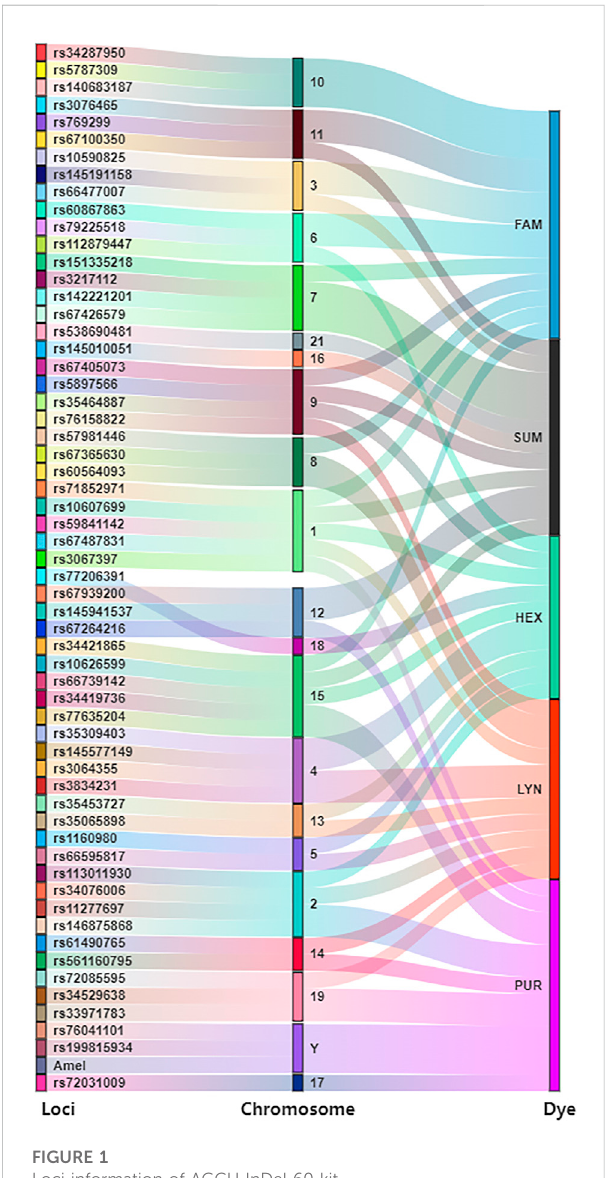
FIGURE 1 Loci information of AGCU InDel 60